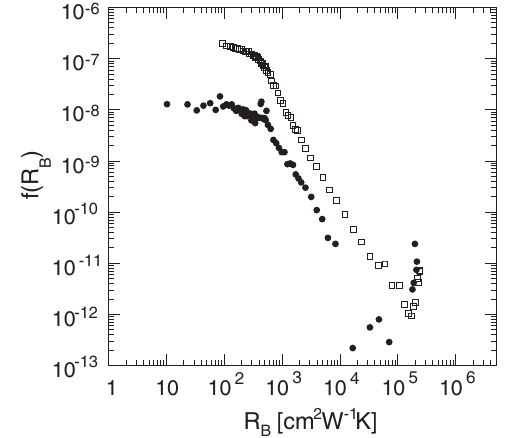
FIG. 10. Converted distribution of thermal boundary resistance. The circle points show 2.4 K data and blank square ones show 4.5 K